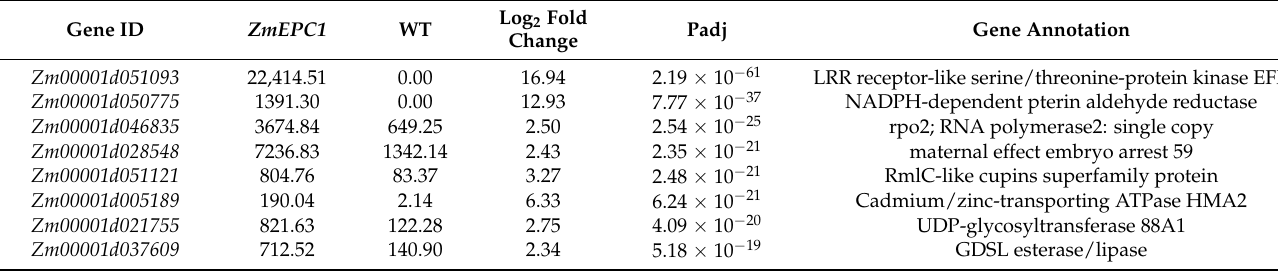
Table 1. Major DEGs screened by transcriptome